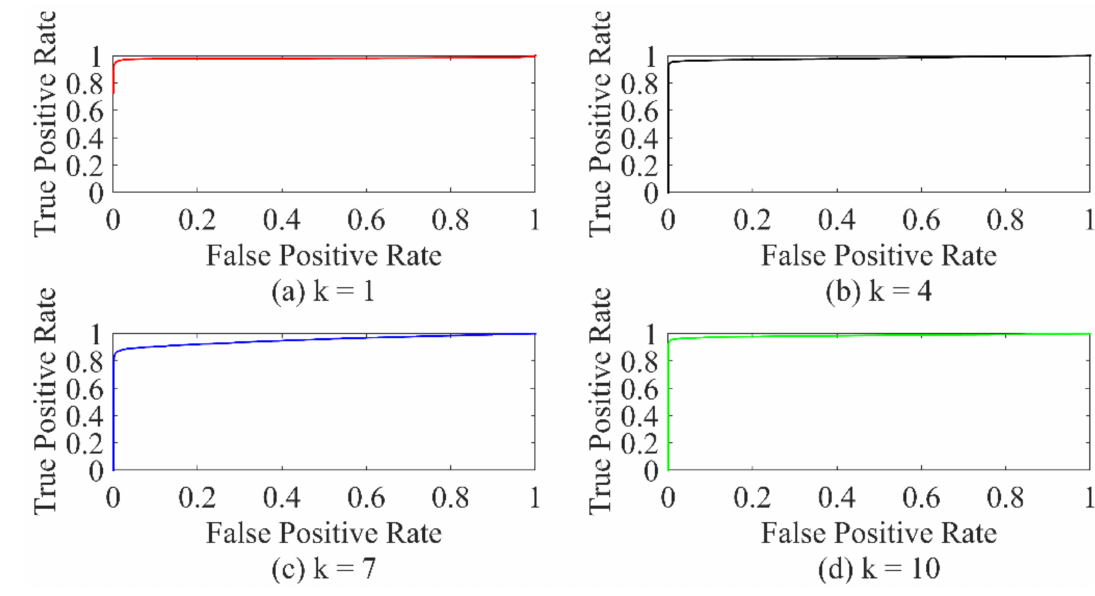
Figure 10. ROC curve when k = 1,4,7,10.